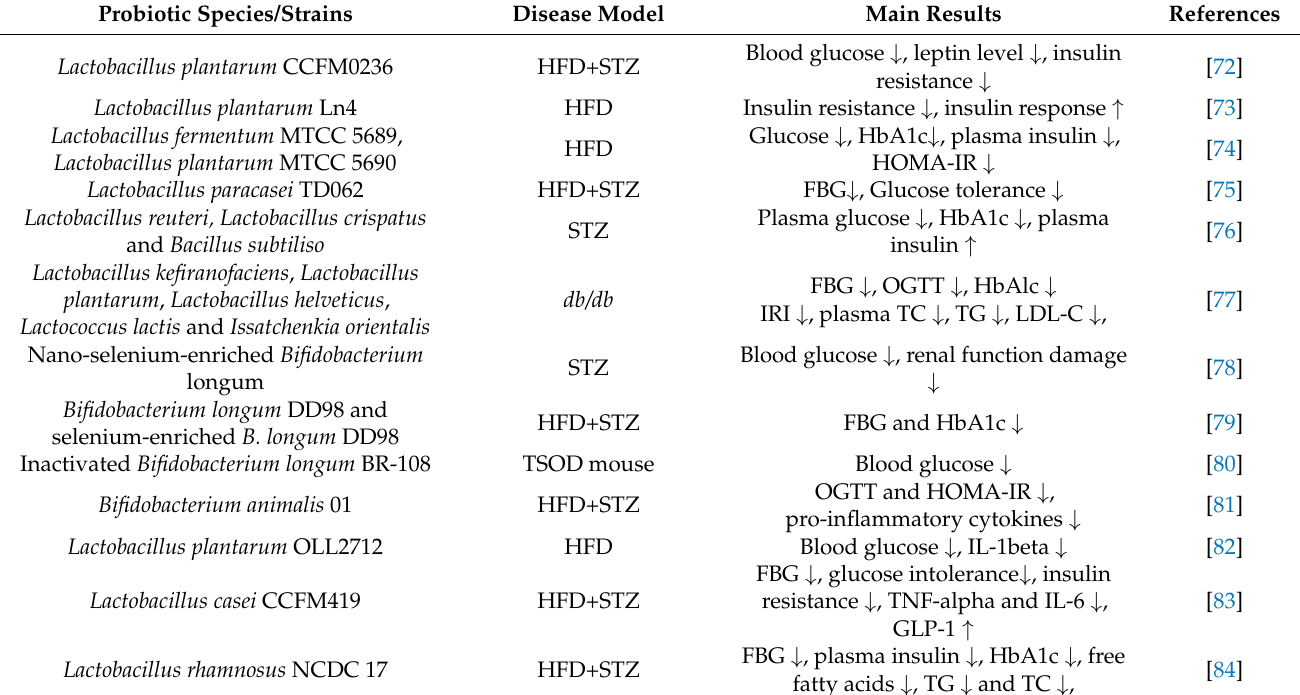
Table 2. Probiotics intervention in animal model of